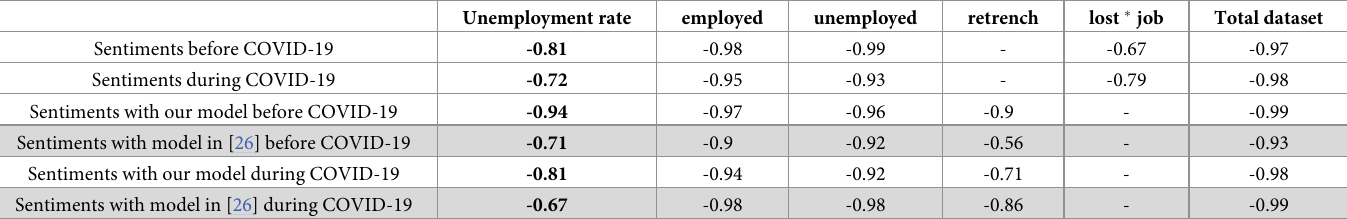
Table 2. Correlation checking. Correlation of the sentiment scores with unemployment rate and the dataset for Nigeria and South Africa.